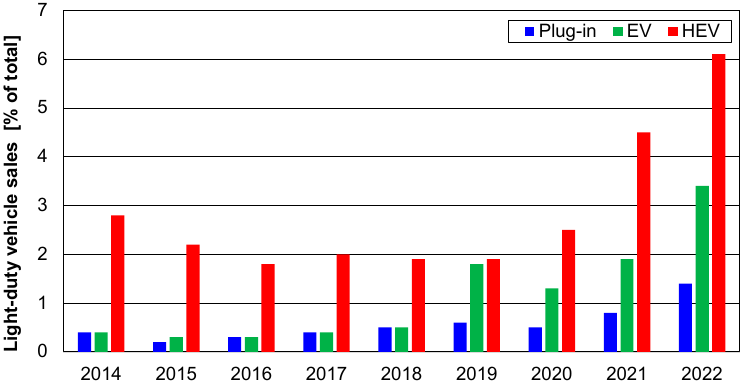
Figure 1. Electric and hybrid light-duty vehicles sales in the US (2014–2021) [4]. According to [1], using plug-in hybridization and other design innovations together, the target can be met without the need for full EVs. The use of mild hybrids is the most effective method of CO 2 weakening, followed by full hybrids and plug-in hybrids, but only if they are operated on battery. The amount of CO 2 produced by electricity generation is greater than for gasoline, but it can be assumed that they are equal.